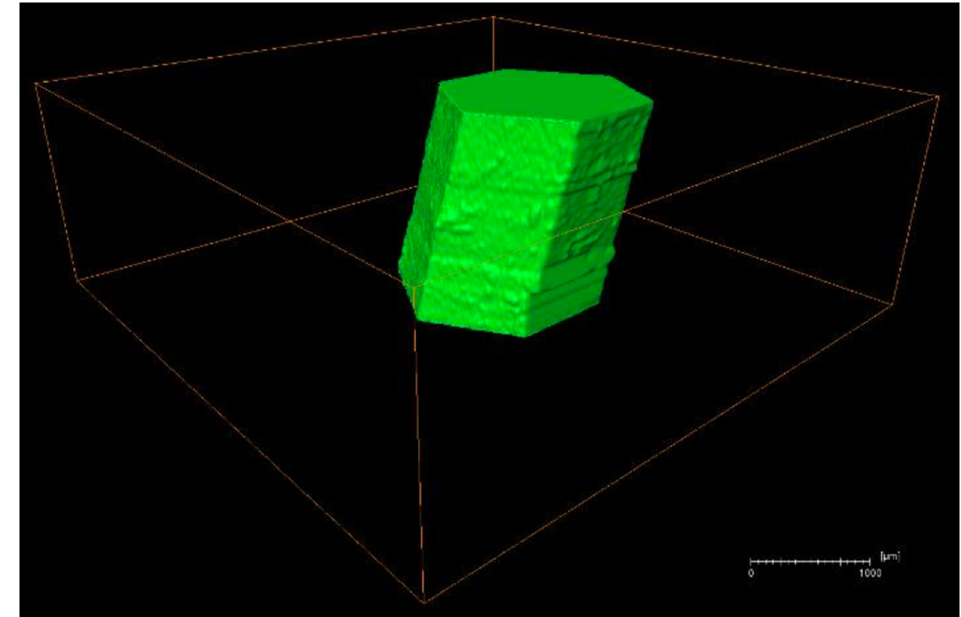
Figure 26. The HRXCT image shows the core as a well-formed hexagonal prism, which takes up 8.25% volume of the host. 8.25% volume of the host.